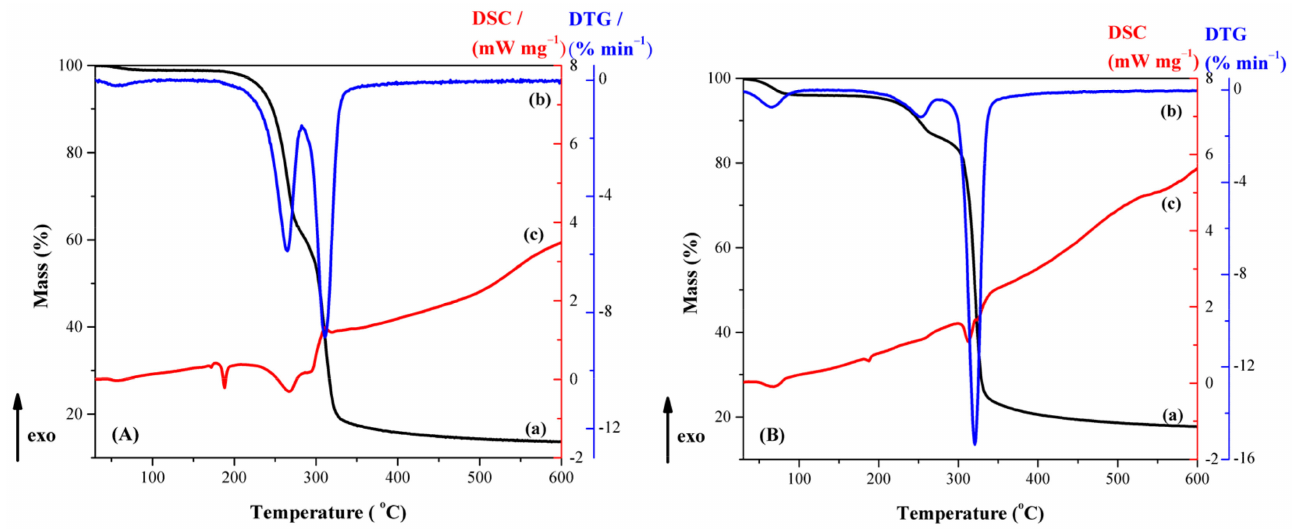
Figure 5. Thermal curves of ( A ) CBZ- β -CD physical mixture and ( B ) CBZ- β -CD inclusion complex, with (a) TG, (b) DTG and (c) DSC (dynamic argon atmosphere, β = 5 ◦ C min − 1 ).